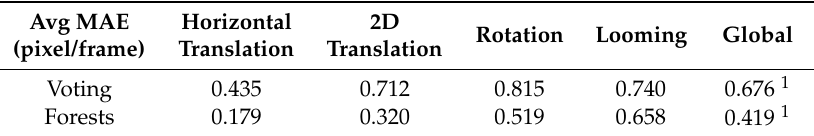
Figure 3. Mean Absolute Errors (MAE) of optical flow computation for more complicated motion patterns. In the looming pattern, each image frame is generated by expanding its preceding frame at a constant expansion rate, and then cropping the frame to leave only the central 320 × 240 region within the frame. Table 1. The average MAEs (lower values indicate better accuracy) of the 4 different motion patterns across their respective speed levels. Avg MAE